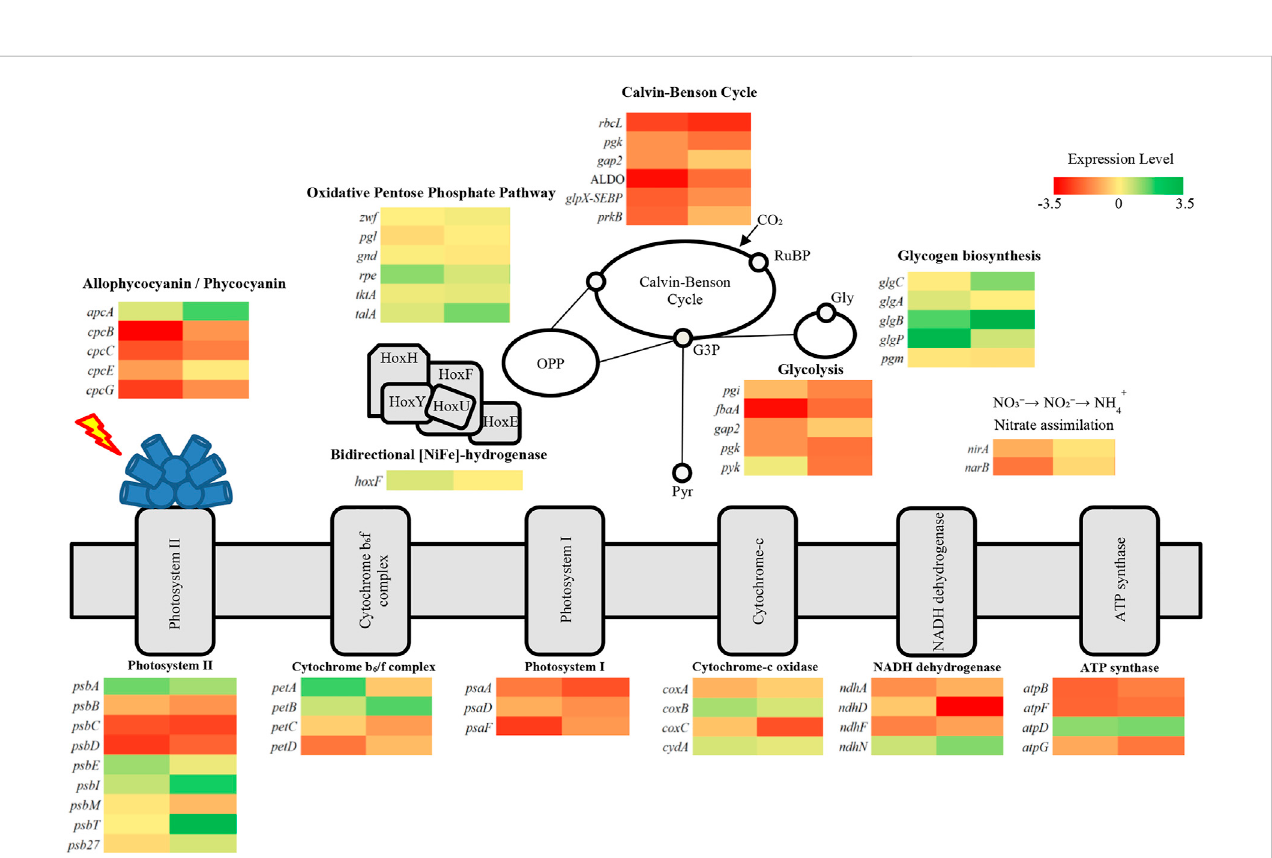
FIGURE 4 Transcriptional level of genes involved in photosynthetic pathway, carbon assimilation such as Calvin-Benson cycle, glycolysis, oxidative pentose phosphate pathway, and nitrate assimilation in A. halophytica. The fi rst column shows differences of gene expression between N-deprived adapted cells and normalcellsandthesecondcolumnshowsdifferencesofgeneexpressionbetweenK-deprivedadaptedcellsandnormalcells.Expressionlevelsareshownas heat maps with gene names, demonstrating different gene expression in many metabolic pathways involved in H 2 production. The metabolic pathways are photosynthesis, oxidative pentose phosphate, glycolytic pathway, glycogen biosynthesis, and nitrate assimilation. Abbreviations: oxidative pentose phosphate pathway, OPP; glucose-3-phosphate, G3P; glycogen, gly; pyruvate, pyr; [NiFe]-bidirectional H 2 ase enzyme subunits,